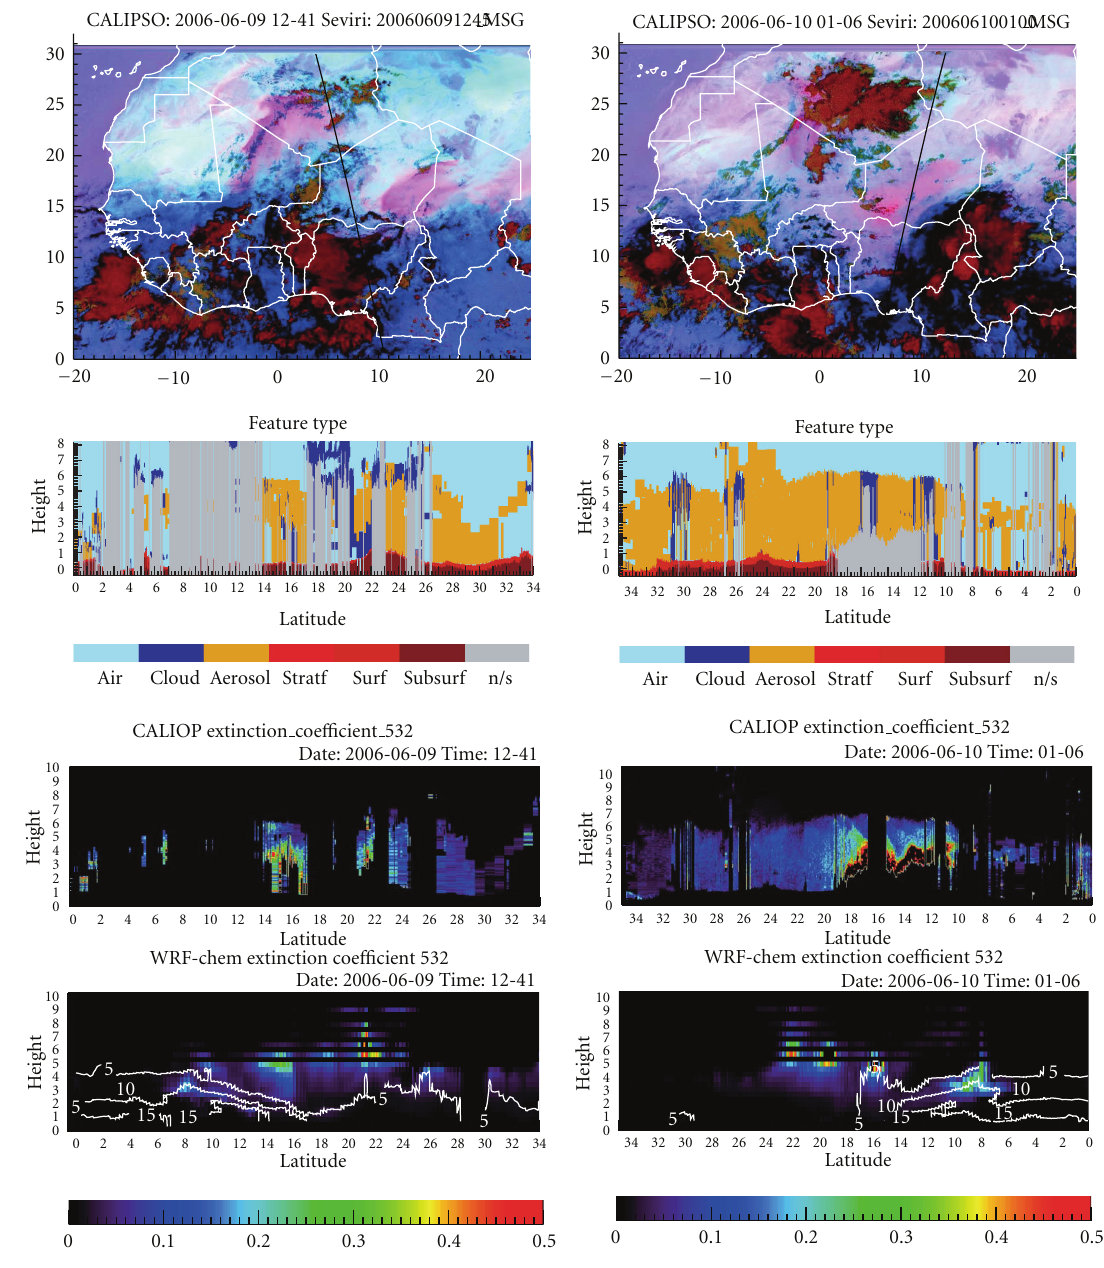
Figure 13: SEVIRI false color dust product imagery. Solid line indicates the CALIPSO track. (b) CALIOP L2 VFM product. (c) CALIOP L2 extinction coe ffi cient (d) WRF-Chem extinction coe ffi cient and water vapor mixing ratio gkg (contour). Left column: day-pass at 12: 41 UTC on the 9th of June, 2006. Right column: night-pass at 01: 06UTC on the 10th of June,